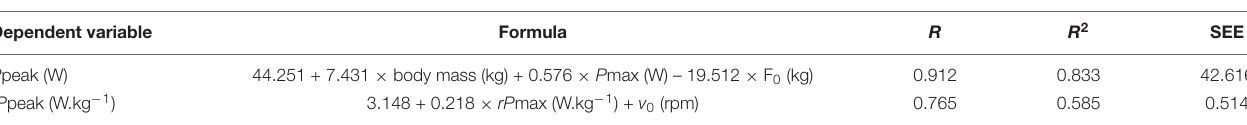
TABLE 3 | Summary of regression analysis in the experimental group ( n = 79).